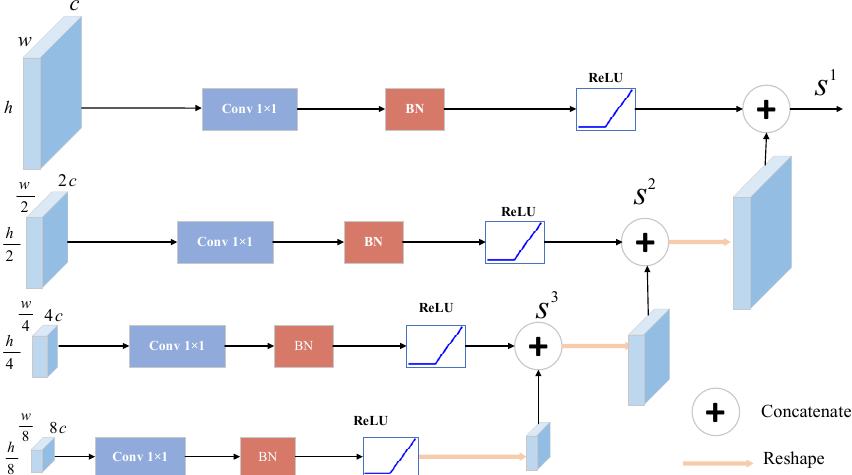
Figure 4. The structure of MFF. h , w and c are respectively the height, width and characteristic channels numbers of the first stage characteristic graph of the first branch. The four-level features in the figure are the output after SSA and its adding process.